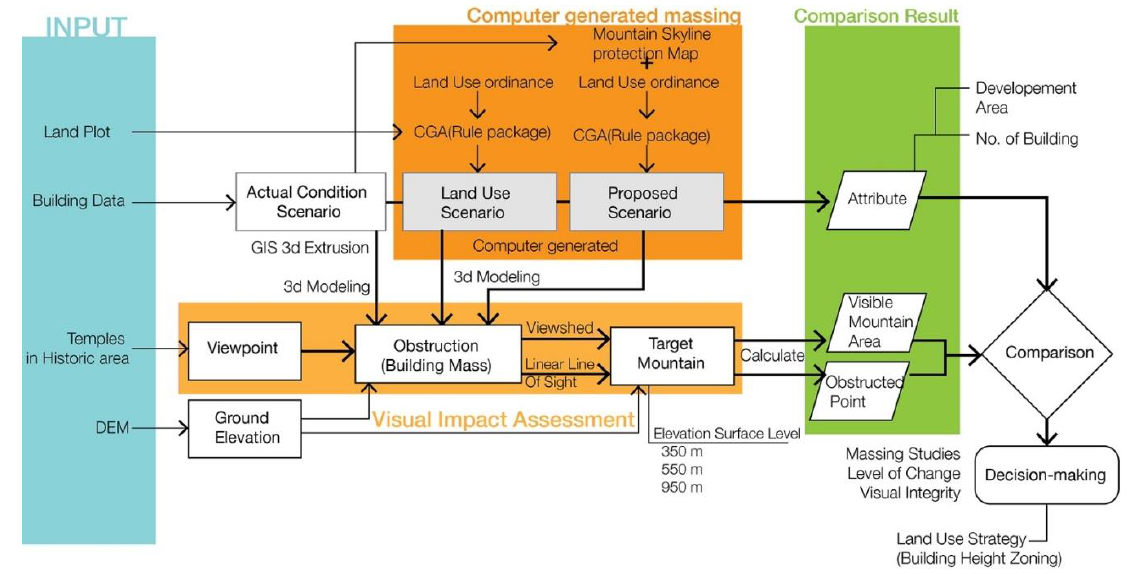
Figure 10. Research methodology.